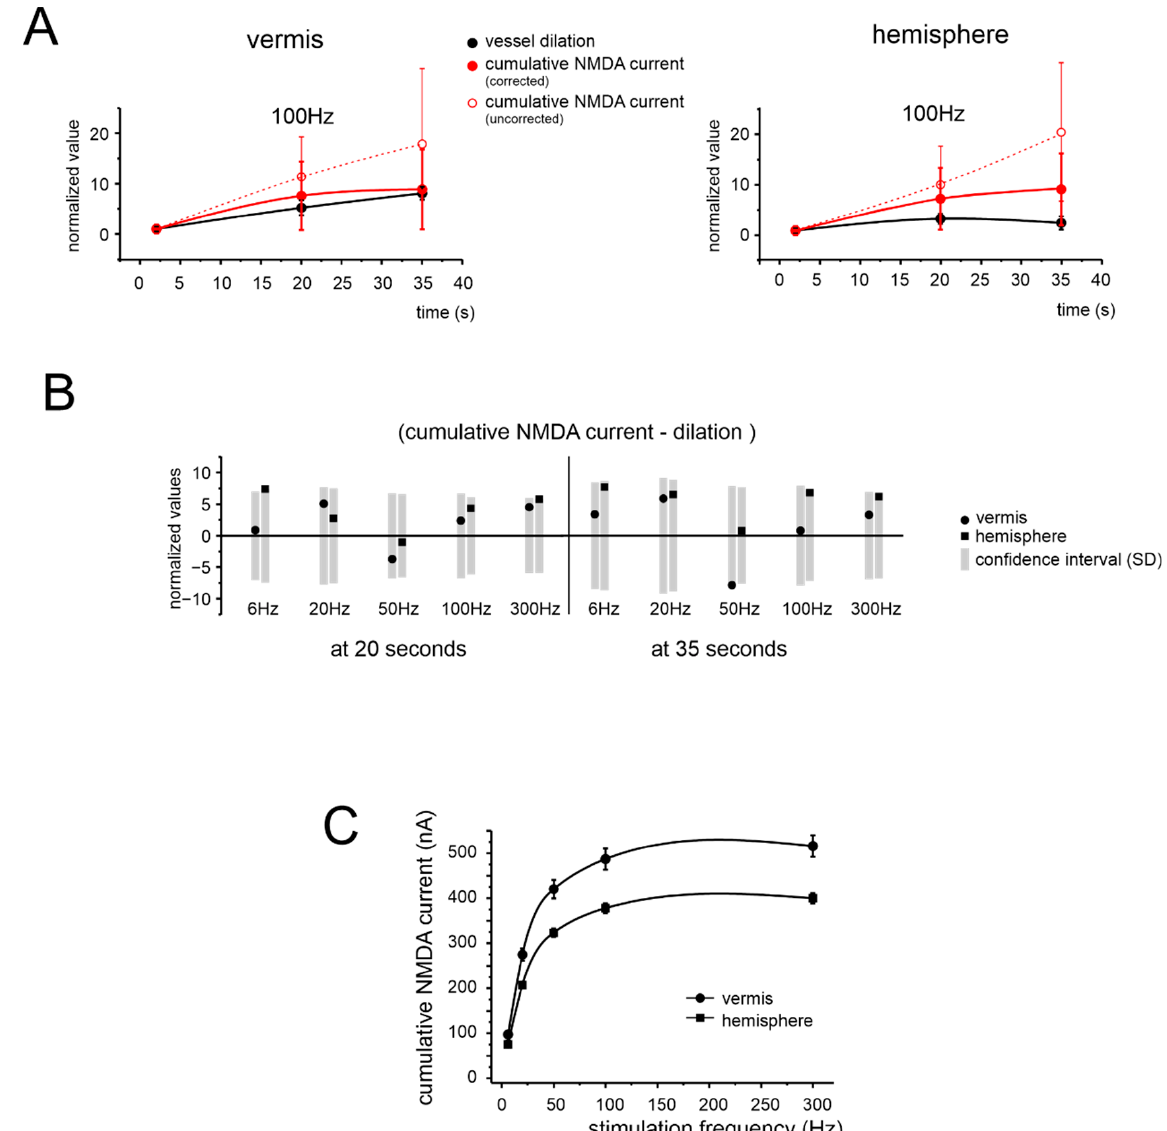
Figure 6. Comparison of simulated NMDA currents in granule cells and blood vessel changes. ( A ) Time course of the granule cells’ cumulative NMDA current during 100 Hz stimulation and of the corresponding vessel response, for the vermis and hemisphere. The plot shows both the corrected and uncorrected NMDA component (see text for details). All data are normalized to amplitude at 2 s. ( B ) The bar graph shows the difference between the normalized values of simulated NMDA components and vessel dilation at 20 and 35 s at all tested frequencies, for the vermis and hemisphere. The grey rectangles represent the normalized confidence interval ( ± 1SD) yielded by model simulations of the NMDA current. Notice that all data points fall within the confidence interval, both for the vermis and hemisphere. ( C ) Frequency dependence of the cumulative NMDA currents measured at 35 s, for the vermis and hemisphere. This panel should be compared to the corresponding one for vasodilation (cf. Figure